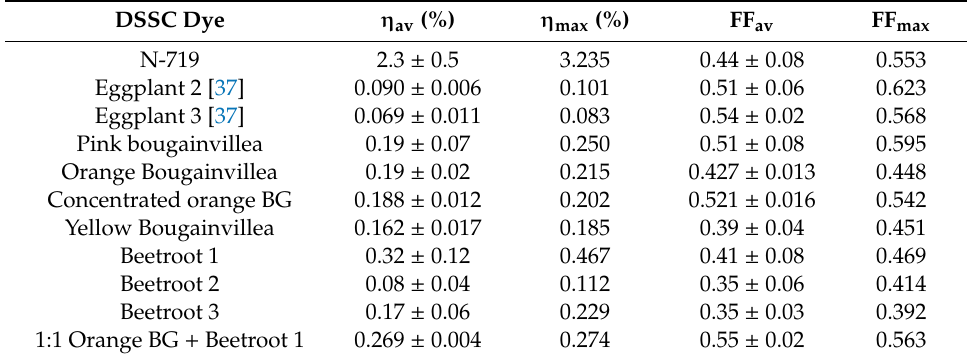
Table 4. Performance of DSSC prepared with natural dyes: Average and maximum e ffi ciency and fill factors. DSSC Dye η av